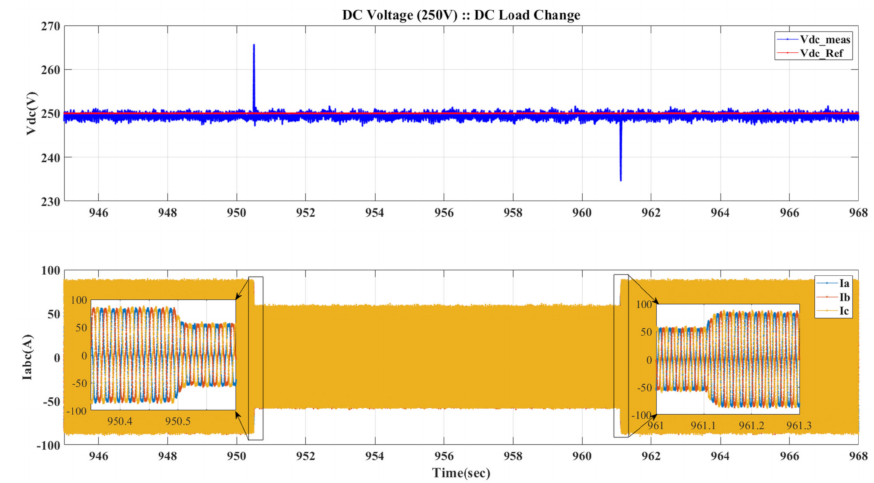
Figure 19. Test 2: DC voltage and three–phase AC